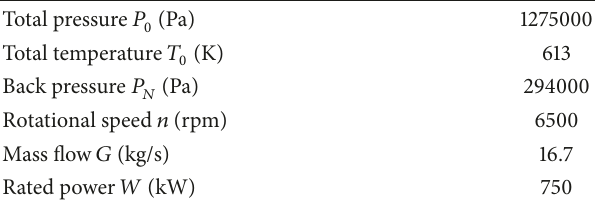
Table 1: The initial design parameters of the centrifugal turbine.